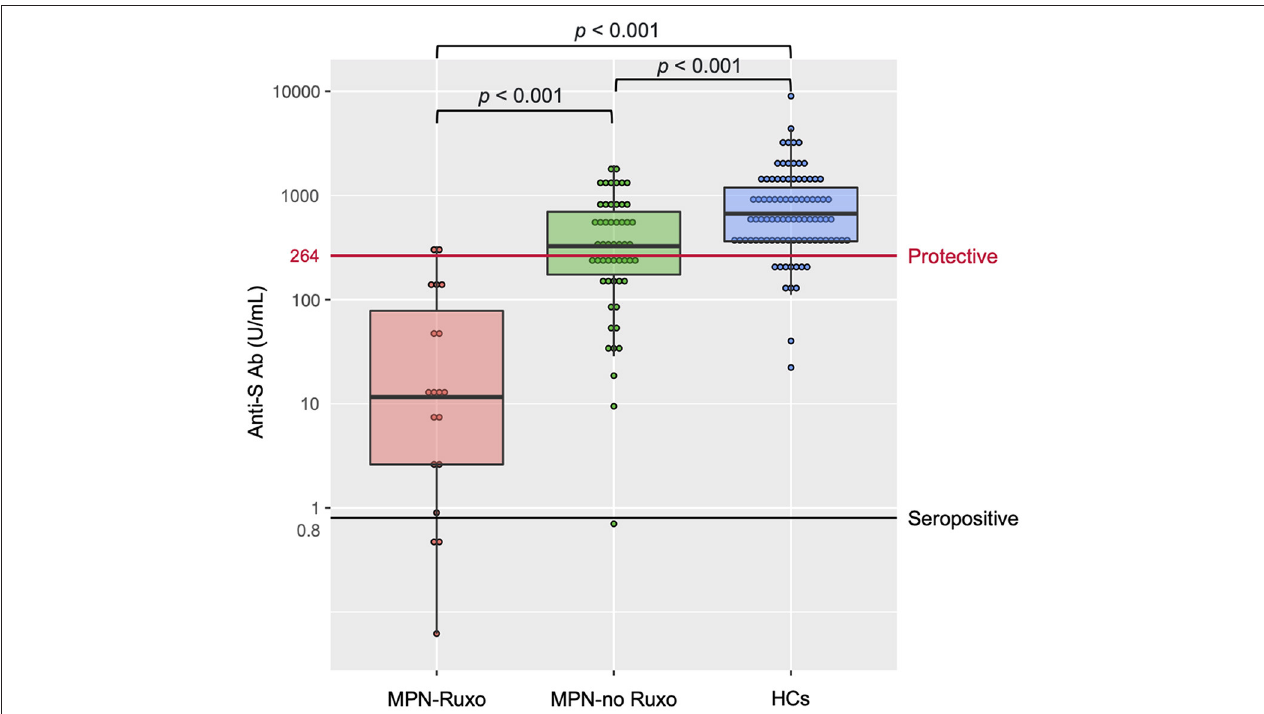
FIGURE 1 | Antibody response after two doses of SARS-CoV-2 vaccine in MPN patients and HCs. MPN, myeloproliferative neoplasms; Anti-S Ab, anti-spike-receptor binding domain antibody; MPN-Ruxo, MPN with ruxolitinib; MPN-no Ruxo, MPN without ruxolitinib; HCs, healthy controls; SARS-CoV-2, severe acute respiratory coronavirus 2.